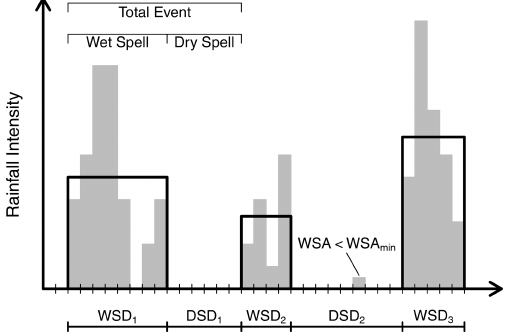
Figure 4. Schematic of the external structure of the ARM model. The black boxes describe rainfall events derived from